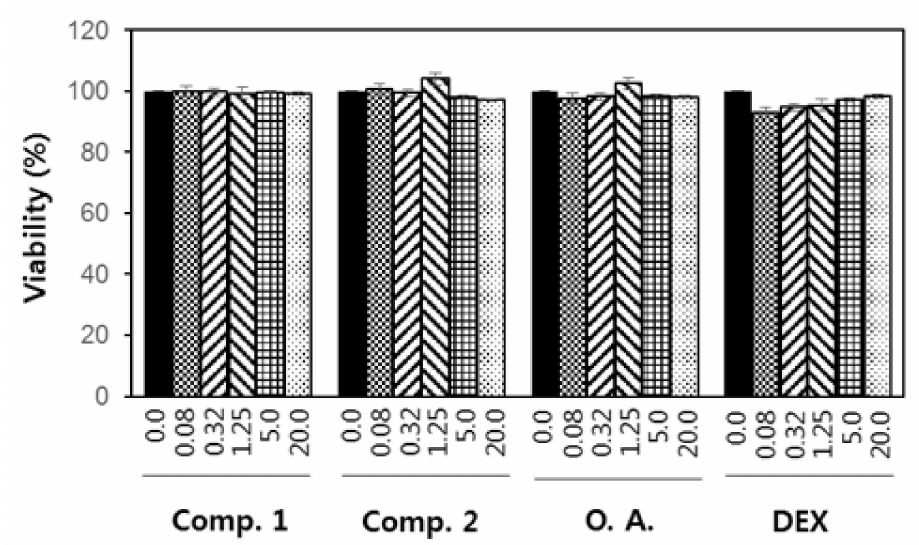
Figure 4. Cytotoxic properties of compounds 1 (Comp. 1 ) and 2 (Comp. 2 ) RAW 264.7 cells after treatment with compounds 1 – 2 , oleanolic acid ( O.A .) and dexamethasone ( DEX ) (0.08, 0.32, 1.25, 5 and 20 µ M, respectively) for 3 days. Dexamethasone was used as the positive control.